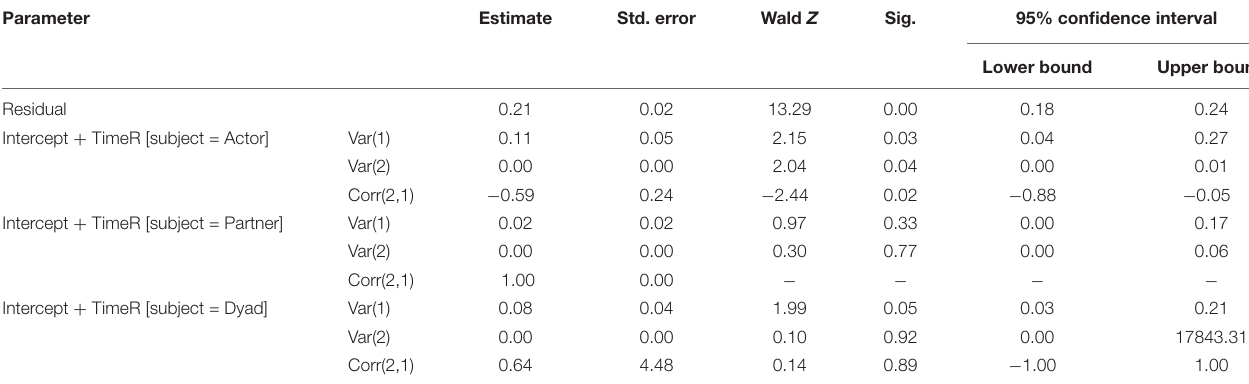
TABLE 5 | Estimates of covariance parameters positive affect (Study 2). Parameter Estimate Std. error